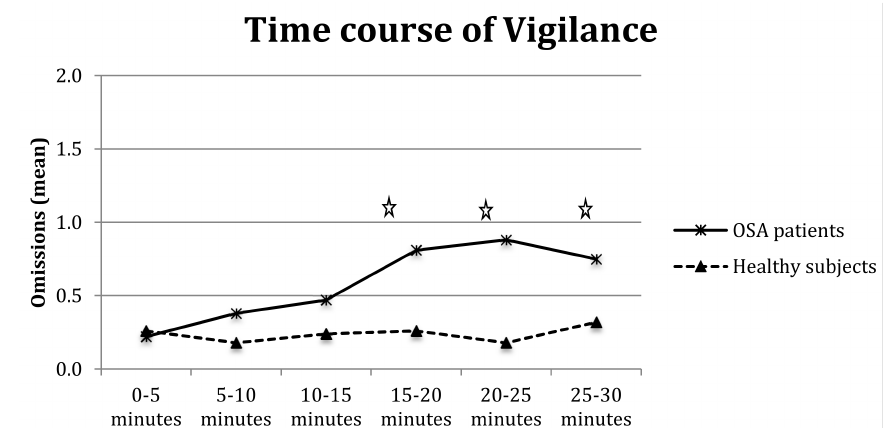
Figure 3. Valid responses of OSA patients and healthy controls in six vigilance intervals. Legend: Stars indicate significant di ff erences.